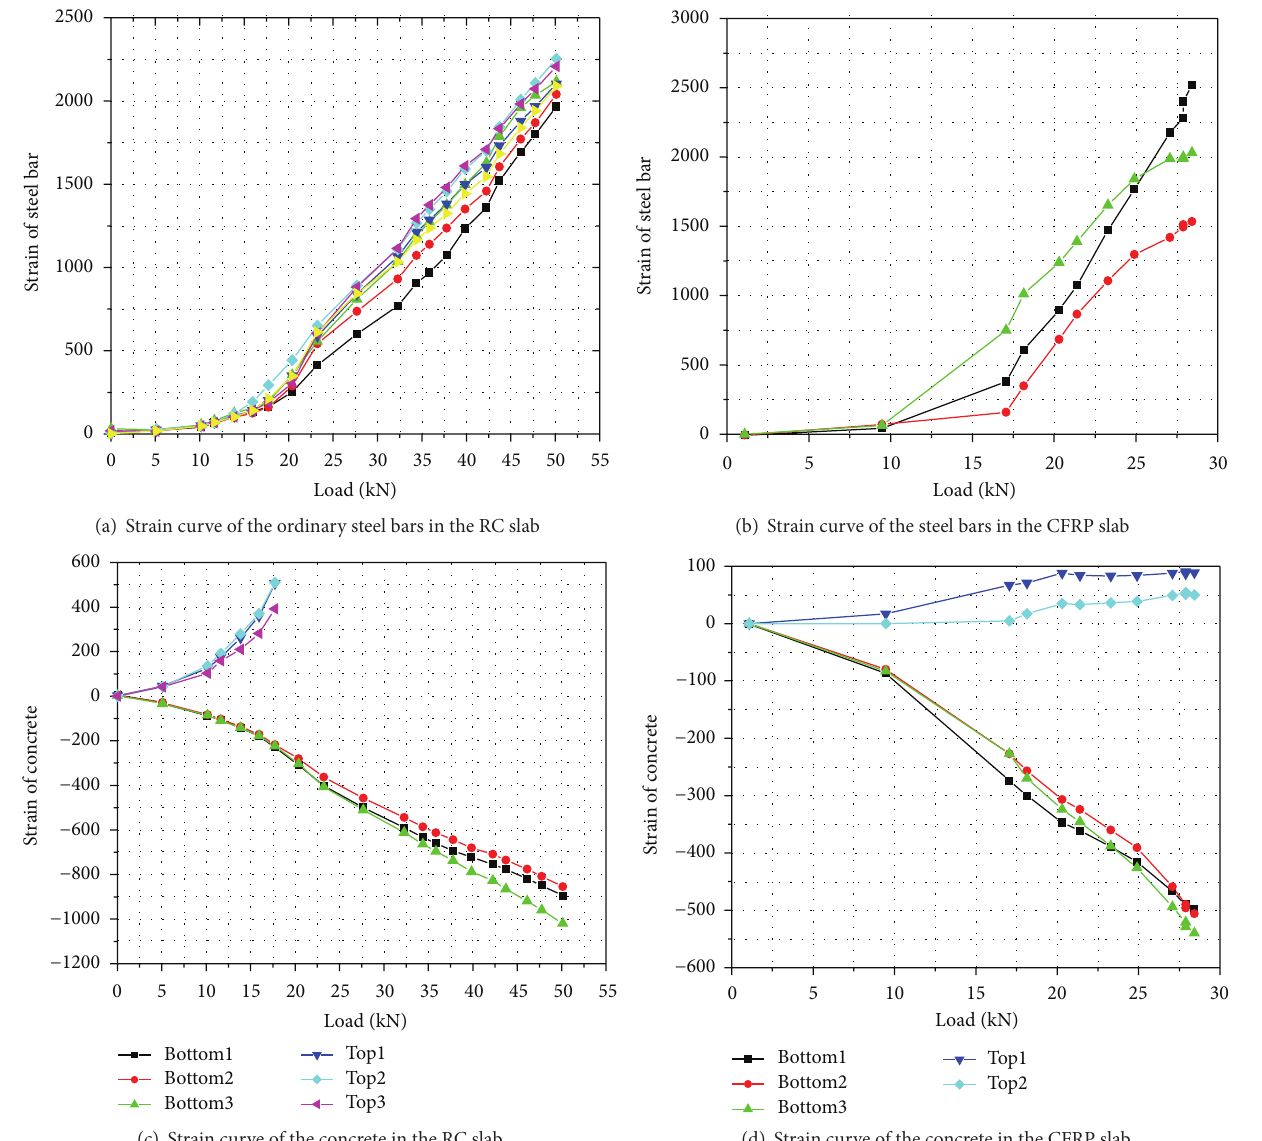
(c) Strain curve of the concrete in the RC slab (d) Strain curve of the concrete in the CFRP slab Figure 13: Strain curves of the concrete and the steel bars at the midspan cross